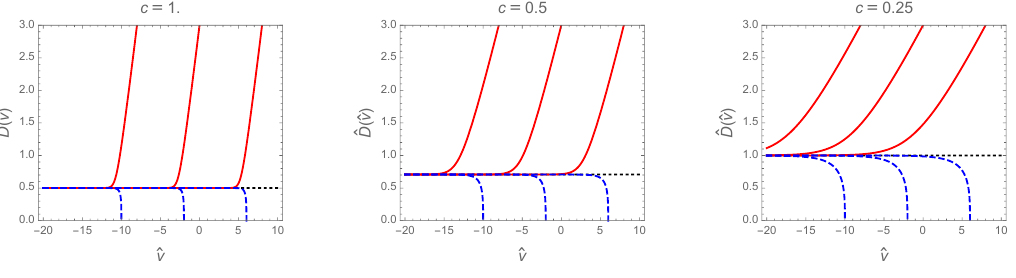
Figure 3 . The three classes of solutions for the function ^ D (^ v ), with positive c , and for (cid:15) = (cid:0) 1. To make it clear that the null coordinate in this case is an advanced time we use ^ v instead of ^ u . Di(cid:11)erent panels display the solutions for three choices of c , namely c = 1 ; 1 = 2, and 1 = 4. Same color coding and line style as in (cid:12)gure